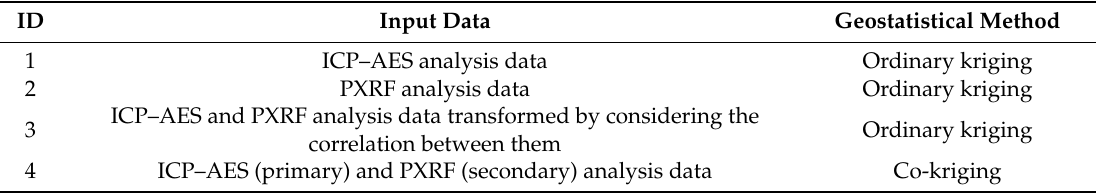
Table 1. Four different approaches designed in this study to generate soil contamination maps for copper and lead by using the inductively coupled plasma atomic emission spectrometry (ICP–AES) and portable X-ray fluorescence (PXRF) analysis